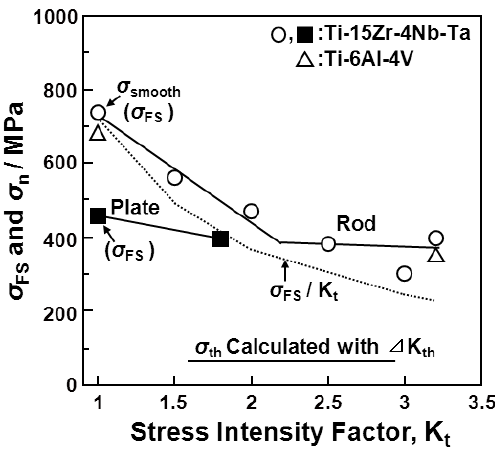
) and fatigue notch sensitivity (q) at 10 7 f